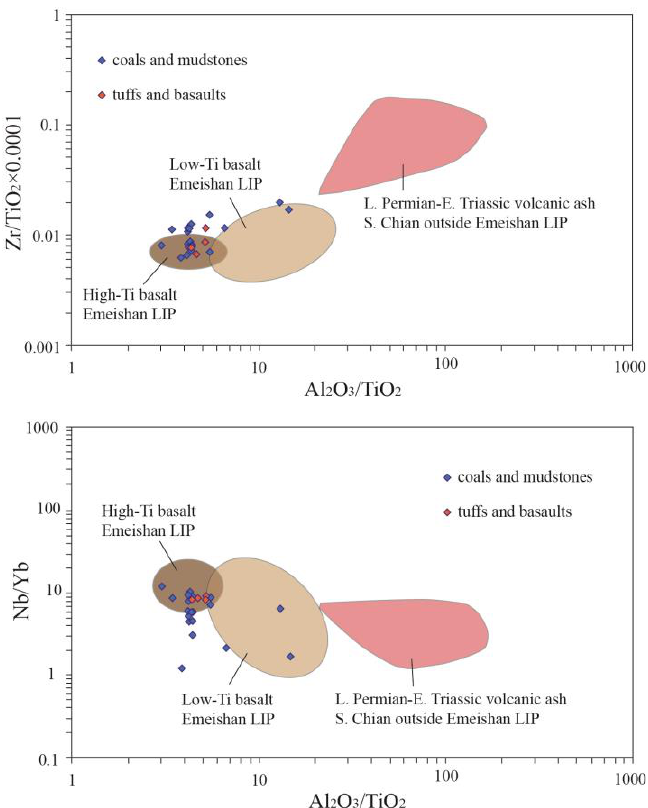
Figure 12. The Al 2 O 3 /TiO 2 -Zr/TiO 2 and Al 2 O 3 /TiO 2 -Nb/Yb diagrams of all the samples. Note: the data of High-Ti basalt, Low-Ti basalt and Late Permian-Early Triassic volcanic ash are reported by Shen et al. [44].